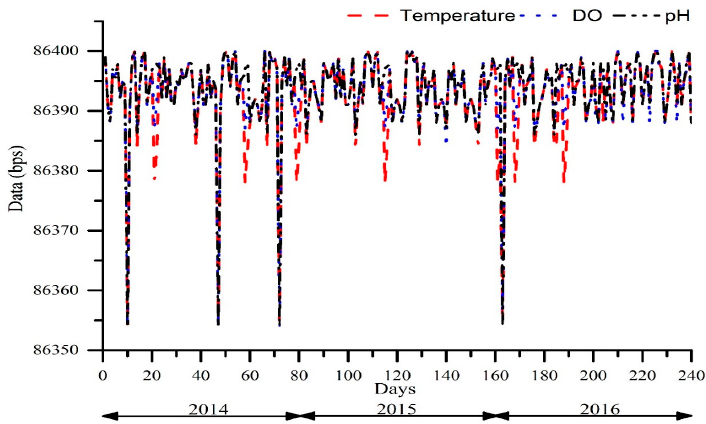
Figure 4. Data in bps received by the main server (MS) during the three summer months and the first fall month for three consecutive years (2014–2016). DO: Dissolved